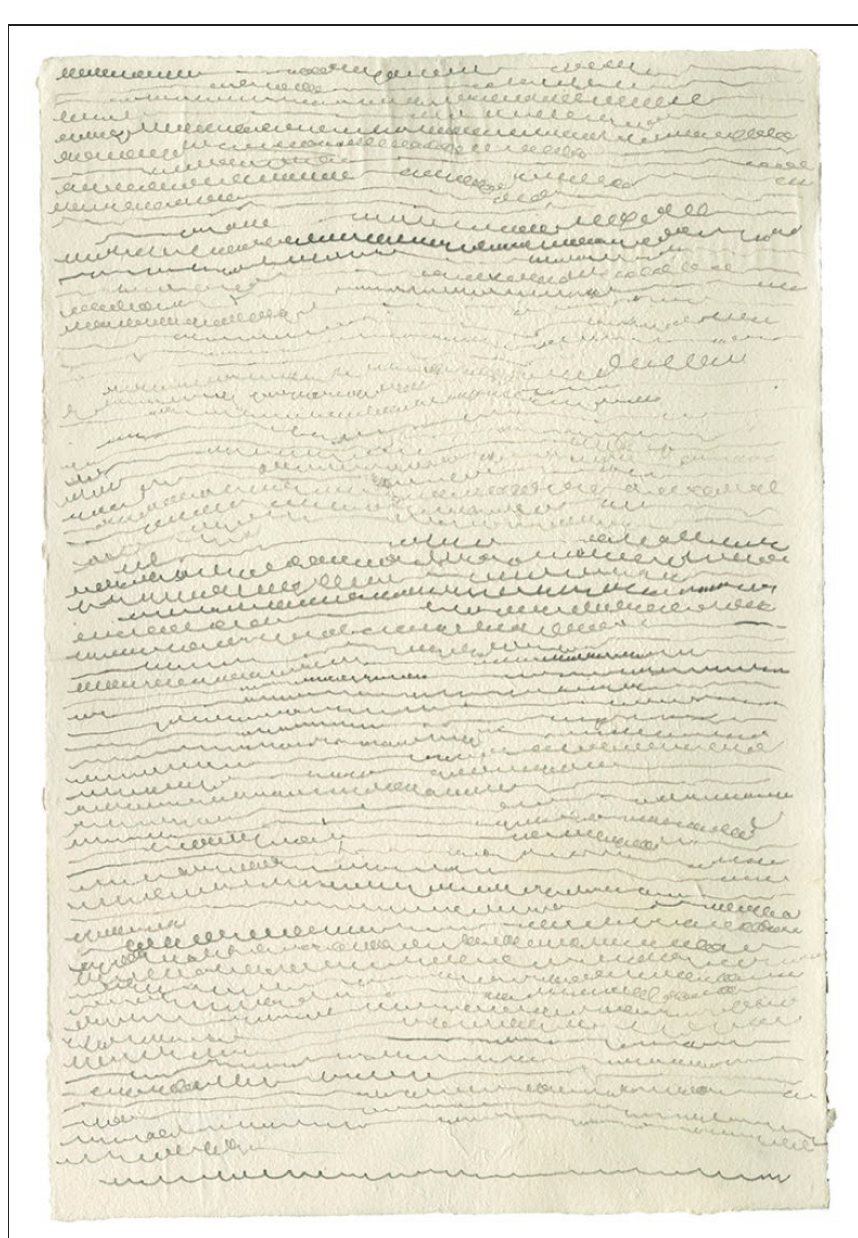
Figure 17: Sarah Irvin, Selection from the Breastfeeding Series , Graphite on paper handmade by the artist, 18 × 12 inches, October 16–16,